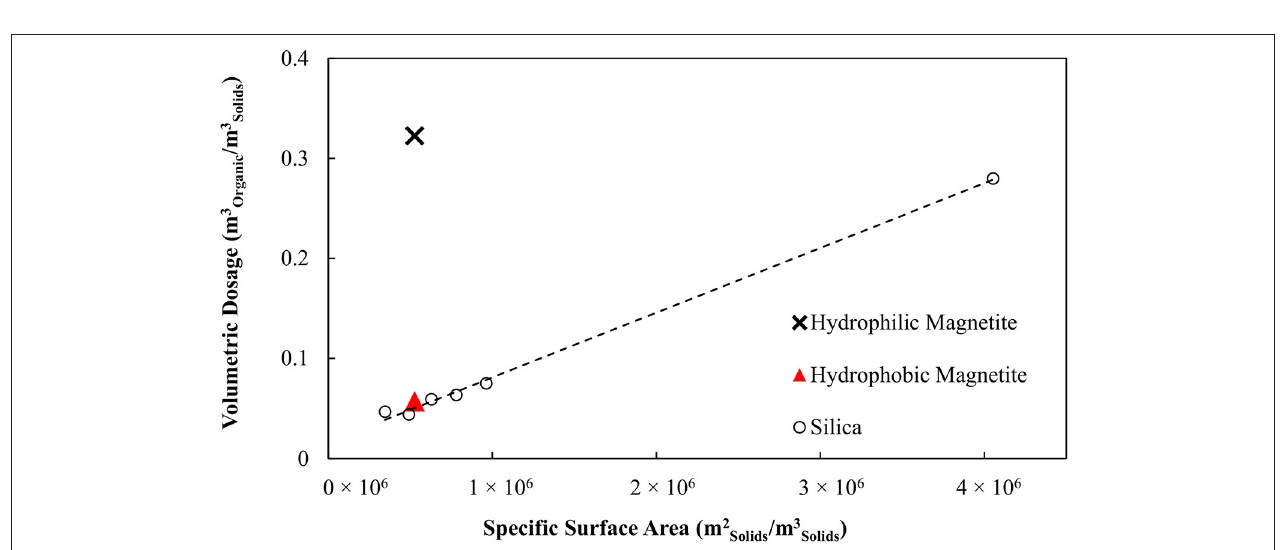
FIGURE 7 | Comparison of organic liquid requirements for magnetite, magnetite conditioned with SMO and silica powders.